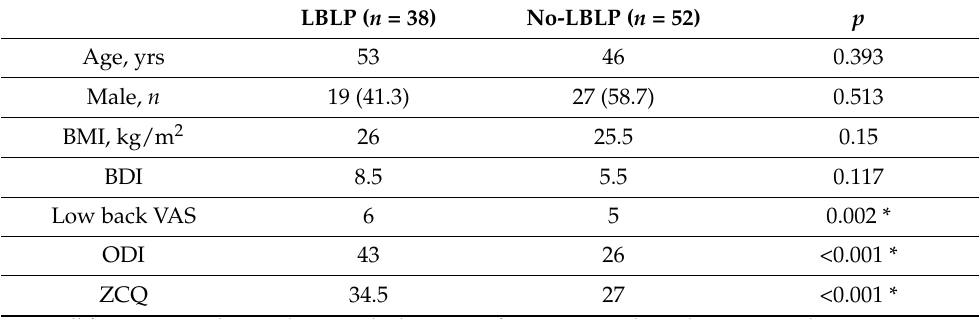
Table 3. Comparison of patients with (LBLP) and without (no-LBLP) low back-related leg